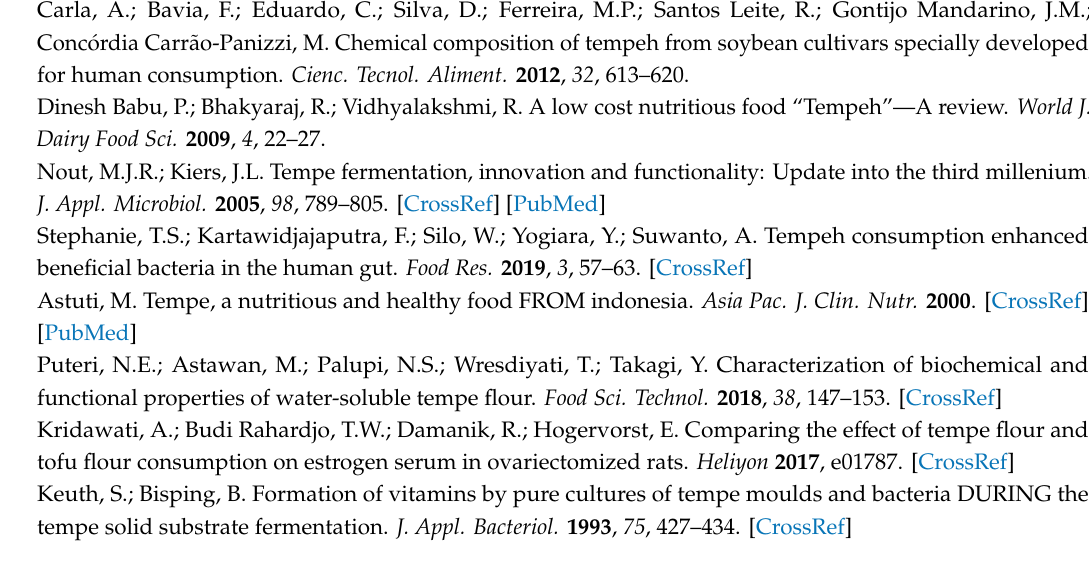
Table S1: Average of temperature and humidity during cross fermentation experiment, Table S2: Sample codes of the validation set, Table S3: Annotated metabolite list of cross fermentation experiment, Table S5: Annotated metabolite list of raw materials experiment, Table S6: Annotated metabolites of starter cultures experiment, Table S7: Soybean in use, Figure S1: Starter culture in use, Figure S2: PCA score plot of three di ff erent soybeans; Figure S3: Cross fermentation